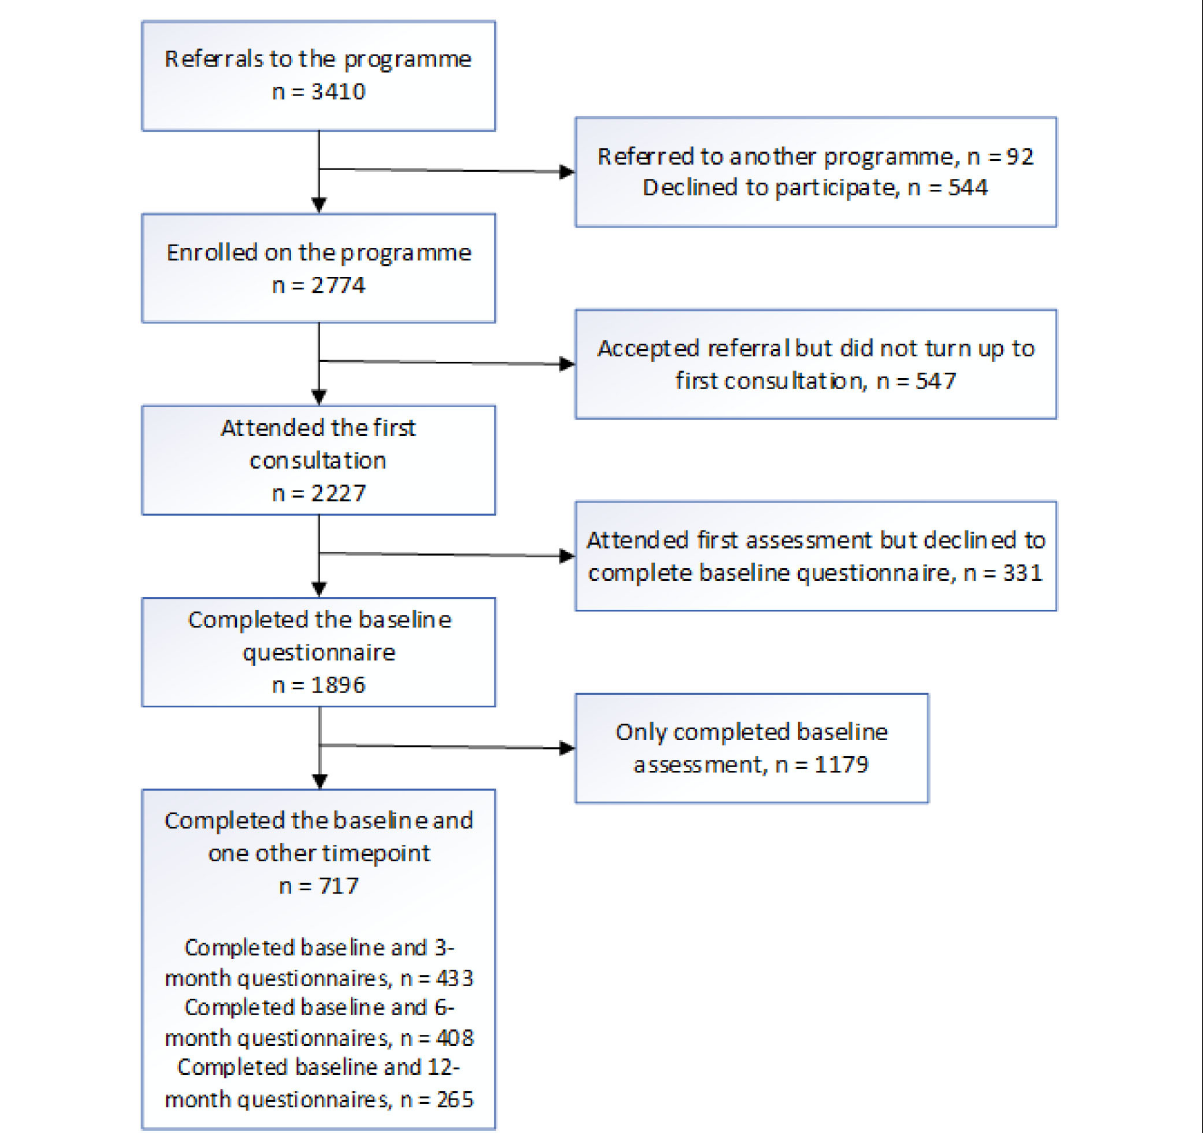
FIGURE1 Participant flowchart for referrals, programme enrolment, consultation, evaluation baseline questionnaire, and follow-up questionnaire completion.